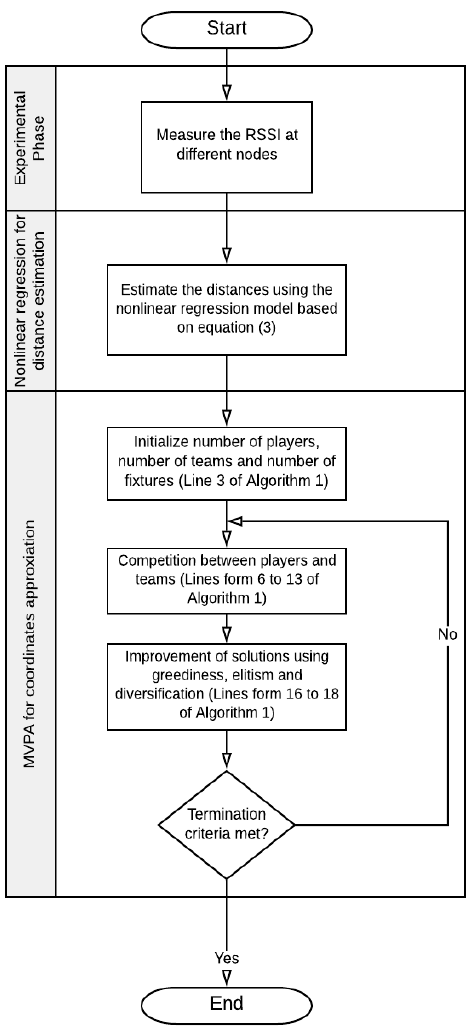
Figure 1. Flowchart of the proposed approach.